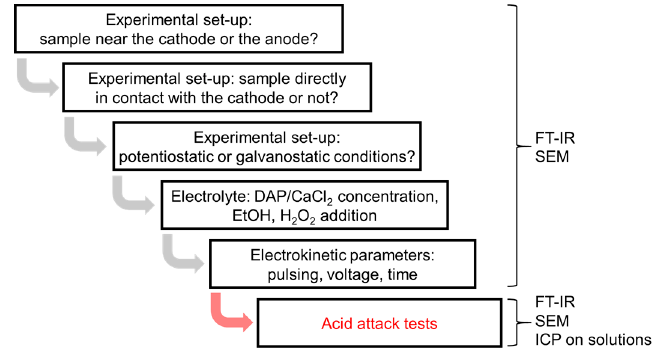
Figure 2 . Scheme summarizing the rationale of the study and the adopted analytical techniques. Figure 2. Scheme summarizing the rationale of the study and the adopted analytical